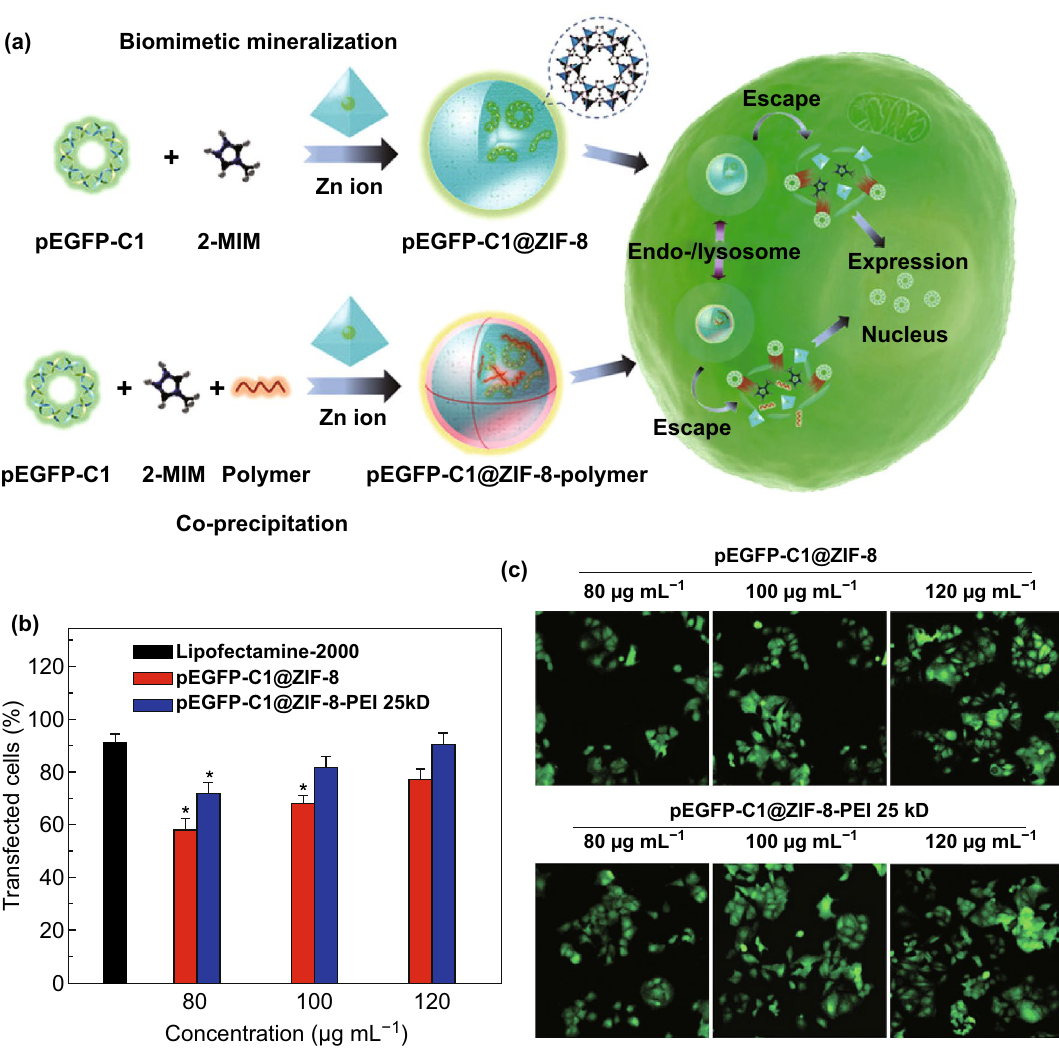
Fig. 10 a Schematic illustration of the synthesis of pEGFP-C1@ZIF-8 via biomimetic mineralization and pEGFP-C1@ZIF-8-polymer via co- precipitation followed by cellular delivery and expression. b Transfection efficacy of pEGFP-C1@ZIF-8, pEGFP-C1@ZIF-8-PEI 25 kD, and lipofectamine-2000 at different concentrations. c Representative CLSM images of pEGFP-C1 expression in MCF-7 cells. Reproduced with per- mission from Ref. [127]. Copyright 2019, WILEY-VCH Verlag GmbH & Co. KGaA,